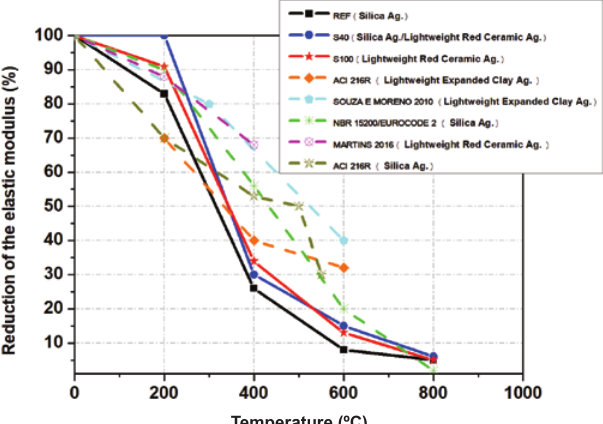
Temperature Figure 3 Reduction values of the elastic modulus of concrete mixtures with substitution percentages of 0%, 40% and 100%